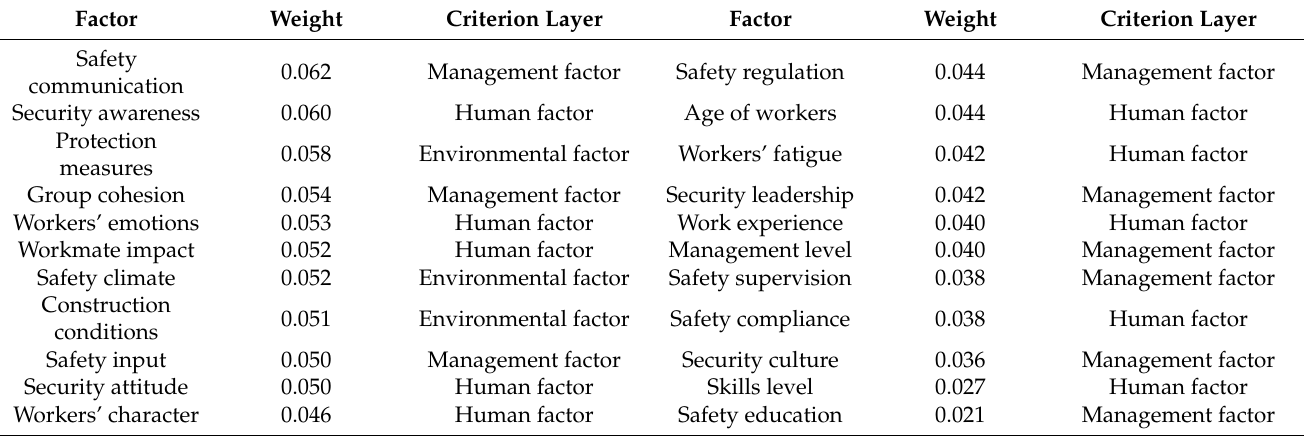
Table 13. The revised